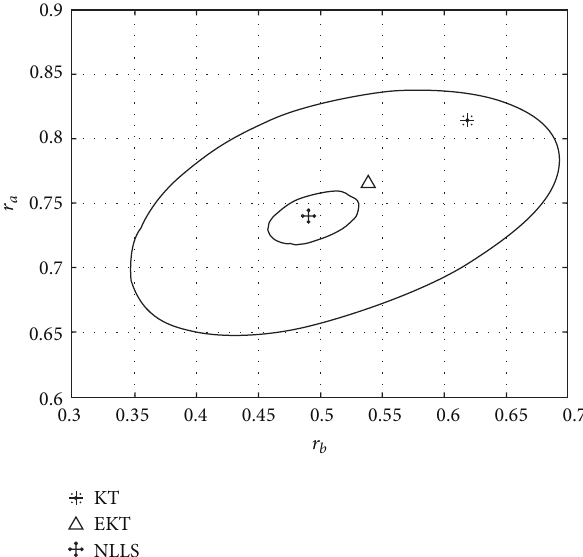
Figure 4: Probability contours and the best fit point (+) obtained by NLLS. Results of EKT ( Δ ) and KT( ∗ ) are also shown on the graph.